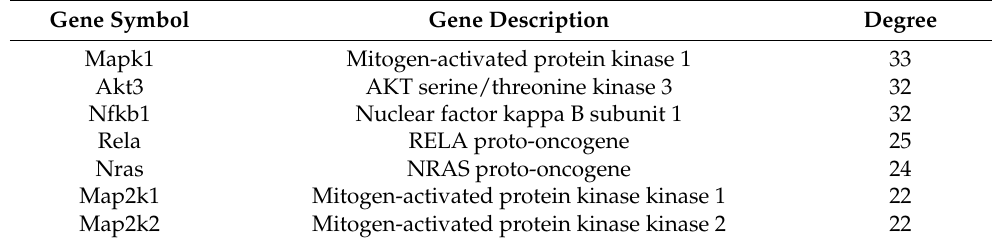
Table 6. The seven hub genes with higher degrees of connectivity.